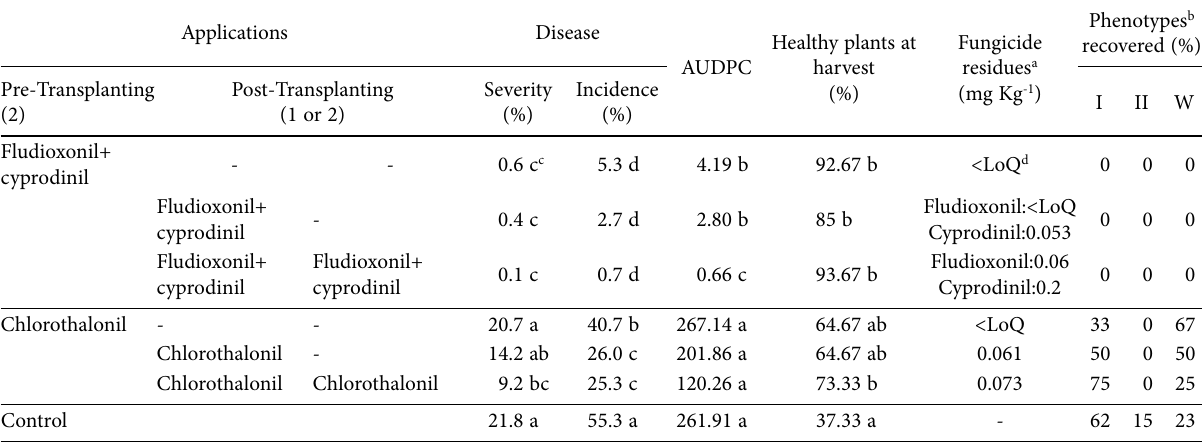
Table 1. Comparison of fungicide spray programs against bottom rot in hydroponic lettuce (Trial 1).